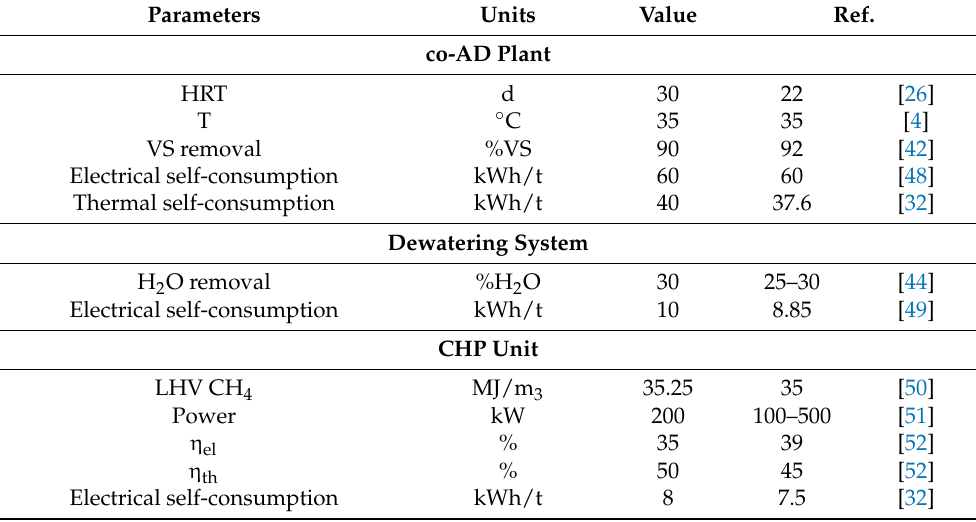
Table 5. The main parameters of the co-AD plant, dewatering system, and CHP unit. Parameters Units Value Ref. co-AD Plant HRT d 30 [26] T ◦ C 35 [4] VS removal %VS 90 92 [42] Electrical self-consumption kWh/t Thermal self-consumption